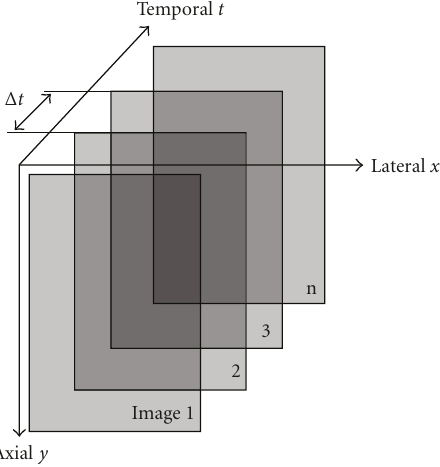
Figure 1: Schematic representation of an image sequence. Δ t is the time interval between two successive frames.